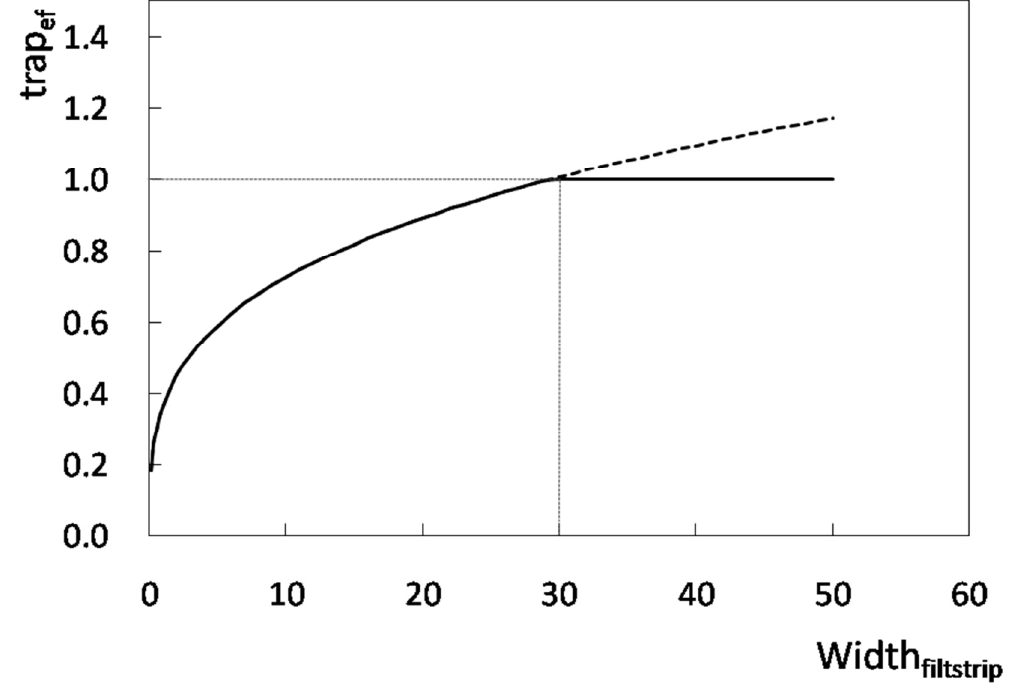
Figure 5. Limitation of sediment trapping efficiency module in current